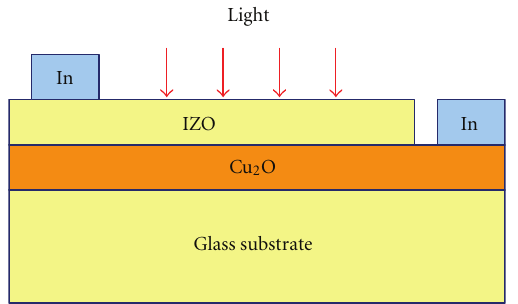
Figure 1: Schematic crosssection of the completed structure.